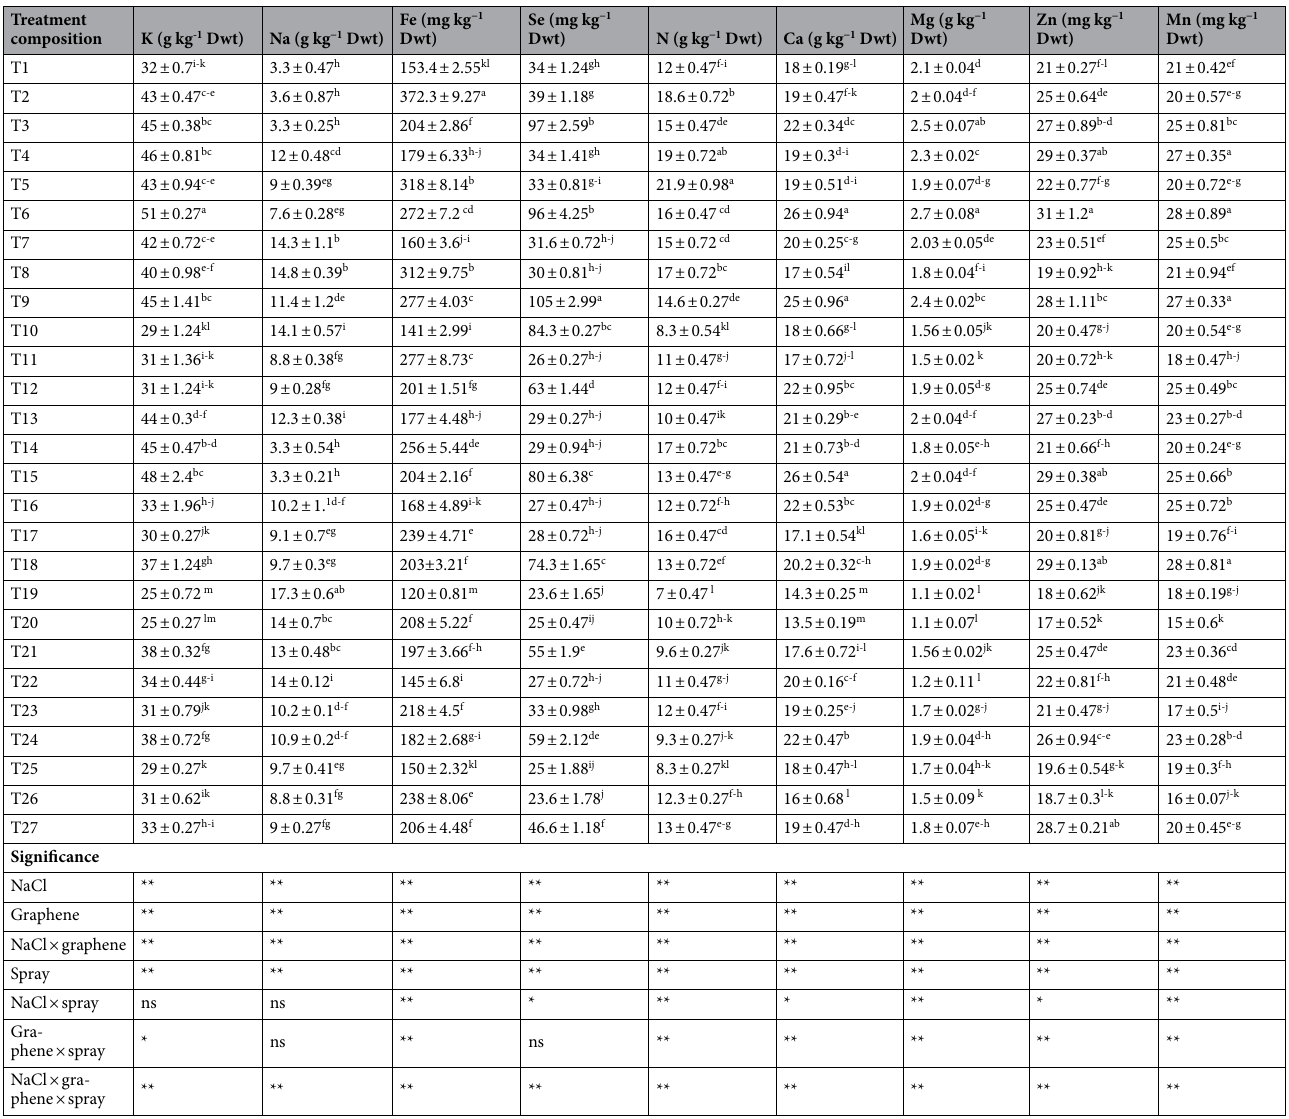
Table 2. Mean comparisons for the effects of soil-based graphene oxide and foliar application with magnetic nano-iron and selenium under salinity on the elemental content of grapevine cv. Sultana. Similar letters show no meaningful difference at 5% probability level by Duncan’s Multiple Range Test. Data are mean ± SD (n = 3 replicates). ns, ** and *: non-significant, significant at 1 and 5 percentage probability levels, respectively. T1: NaCl 0 × graphene 0 × Spray 0 ; T10: NaCl 50 × graphene 0 × Spray 0 ; T19: NaCl 100 × graphene 0 × Spray 0 . T2: